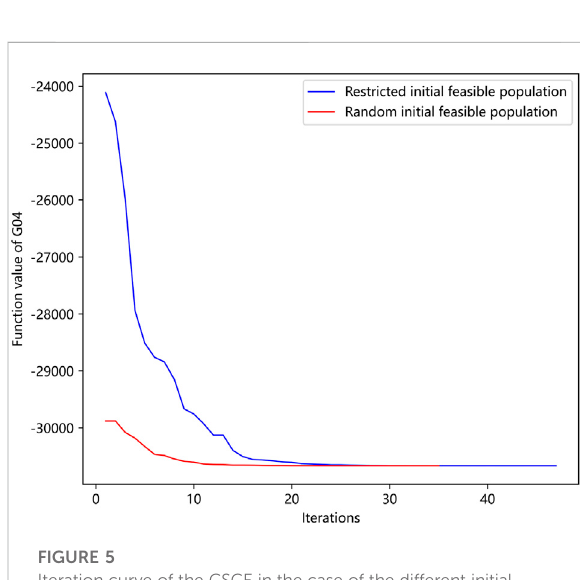
FIGURE 5 Iteration curve of the CSCE in the case of the different initial